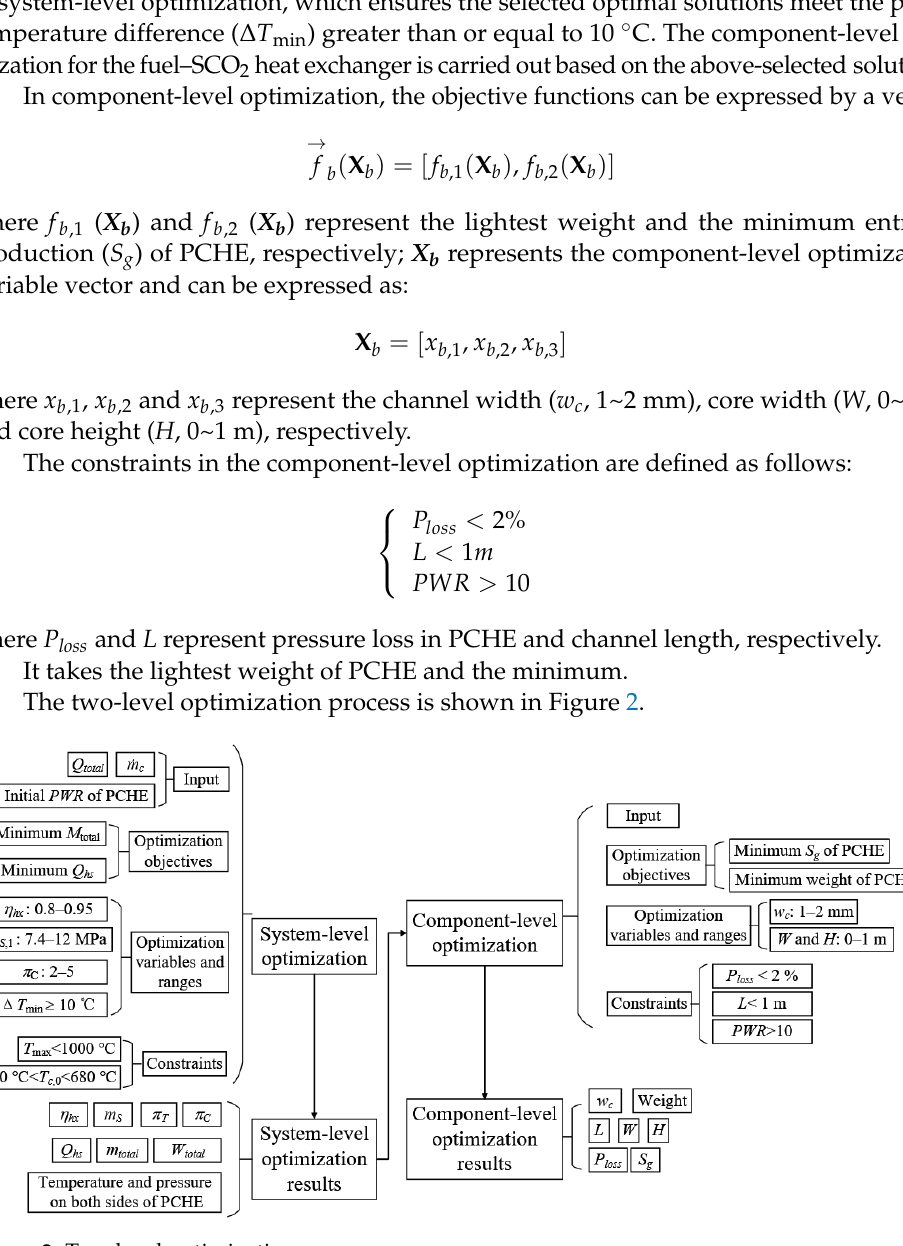
Figure 2. Two-level optimization process. The basic parameters of optimization are shown in Table 1. Table 1. Basic parameters of